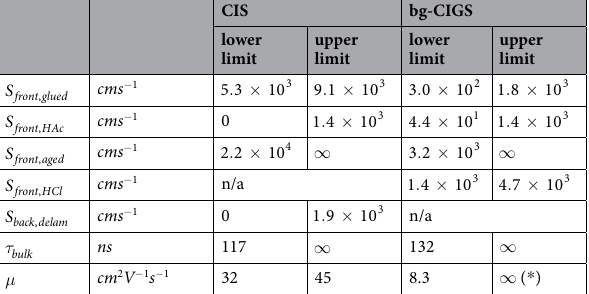
model of Eqn. (11): by imposing the same μ τ S , , was set to − cms 1 1 , which represents a passivated back contact.